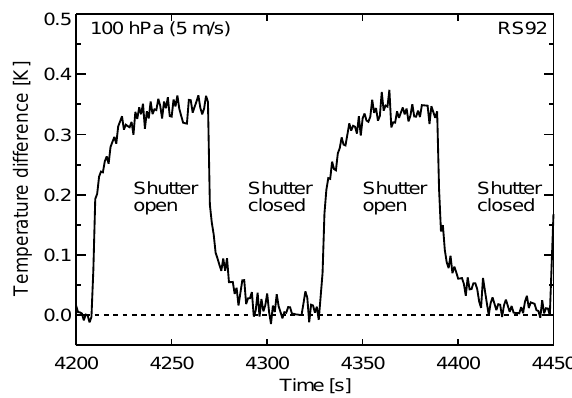
10) Wm − 2 during the ±